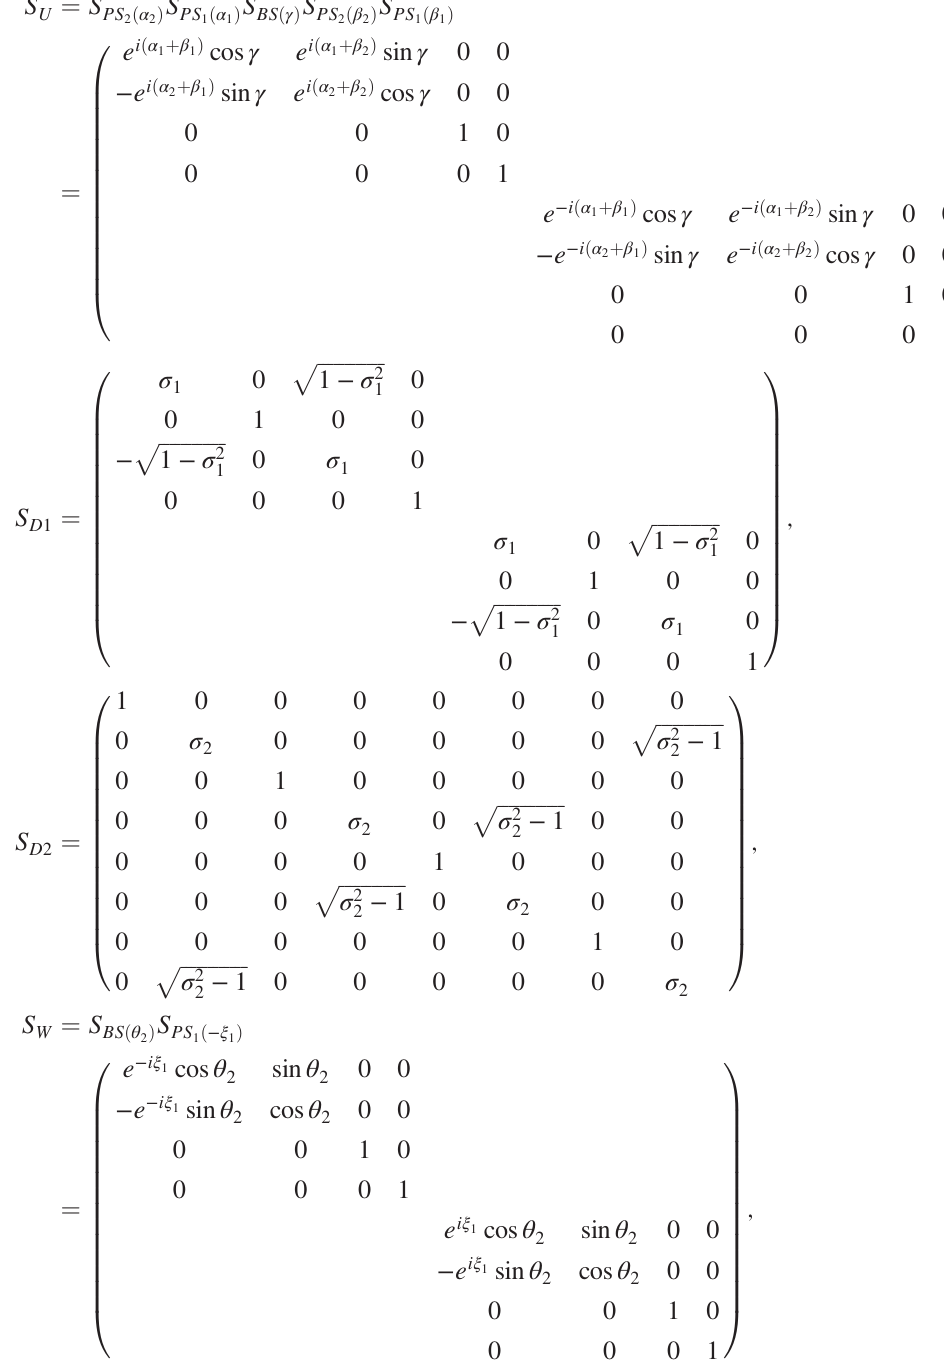
ffiffiffiffiffiffiffiffiffiffiffiffiffi p 1 − σ 2 1 ffiffiffiffiffiffiffiffiffiffiffiffiffi p σ 2 − 1 2